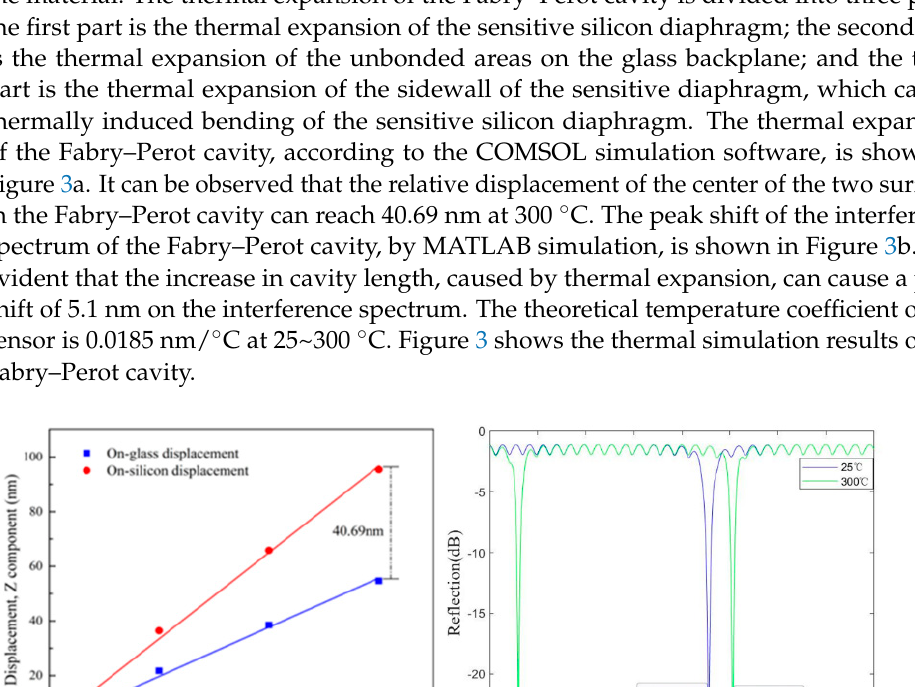
Table 1. The parameters of fiber-optic Fabry–Perot pressure sensor.